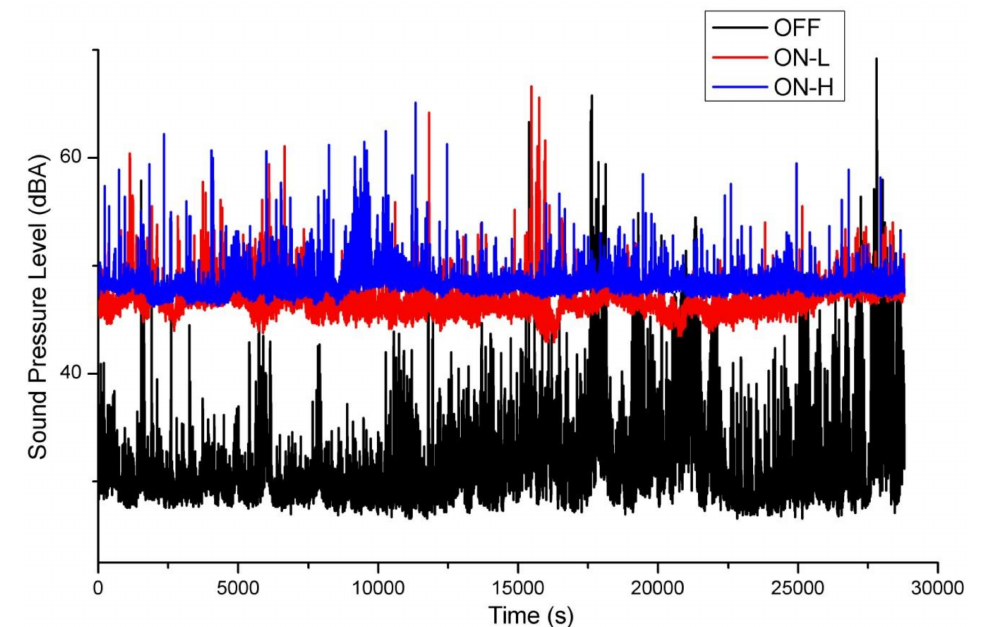
Figure 3. Time history of the three operating conditions (OFF (HAVC off = background noise), ON-L (HAVC on low speed), and ON-H (HAVC on high speed)).